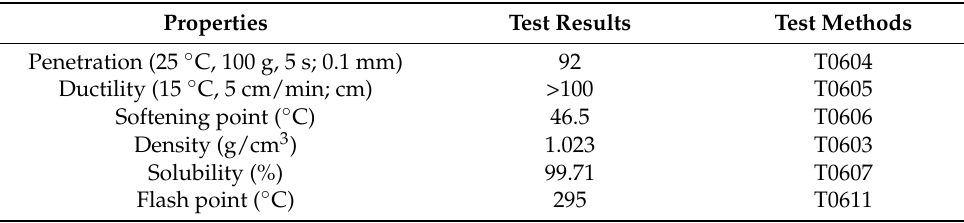
Table 1. Properties of the original asphalt.